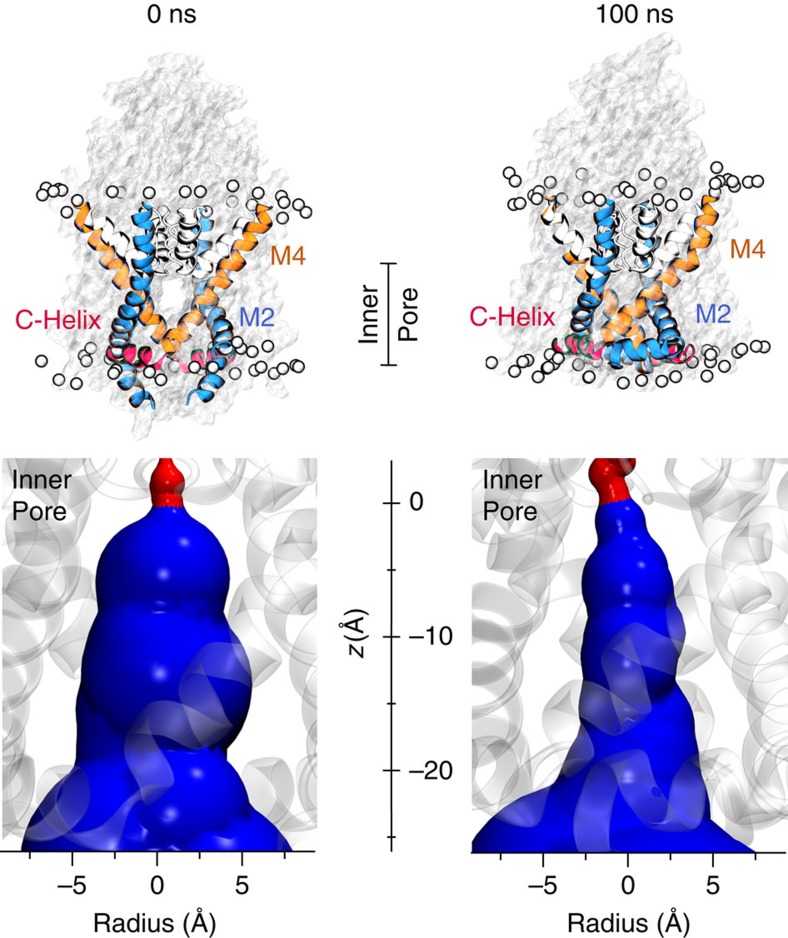
TWIK-1 cytoplasmic gate remains open.Top: pore-lining structure and surface of TWIK-1 at the start (0 ns), and end (100 ns) of the MD simulation. The pore-lining helices and C-helix are highlighted. The position of the membrane is shown by the phosphorus atoms of POPC highlighted as light grey spheres. The C-helix remains stable and associated with the membrane throughout the simulation (Supplementary Fig. 1). Below each snapshot of the simulation is an expanded view of the inner-pore section indicated by the line in the top panel. Distances along the z-axis of the inner pore start below the S4 binding site. The pore radius dimensions show that the cytoplasmic mouth of the inner cavity remains open throughout the simulation. The HOLE surface profiles are coloured red (r<1.2 Å) or blue (r>1.2 Å).